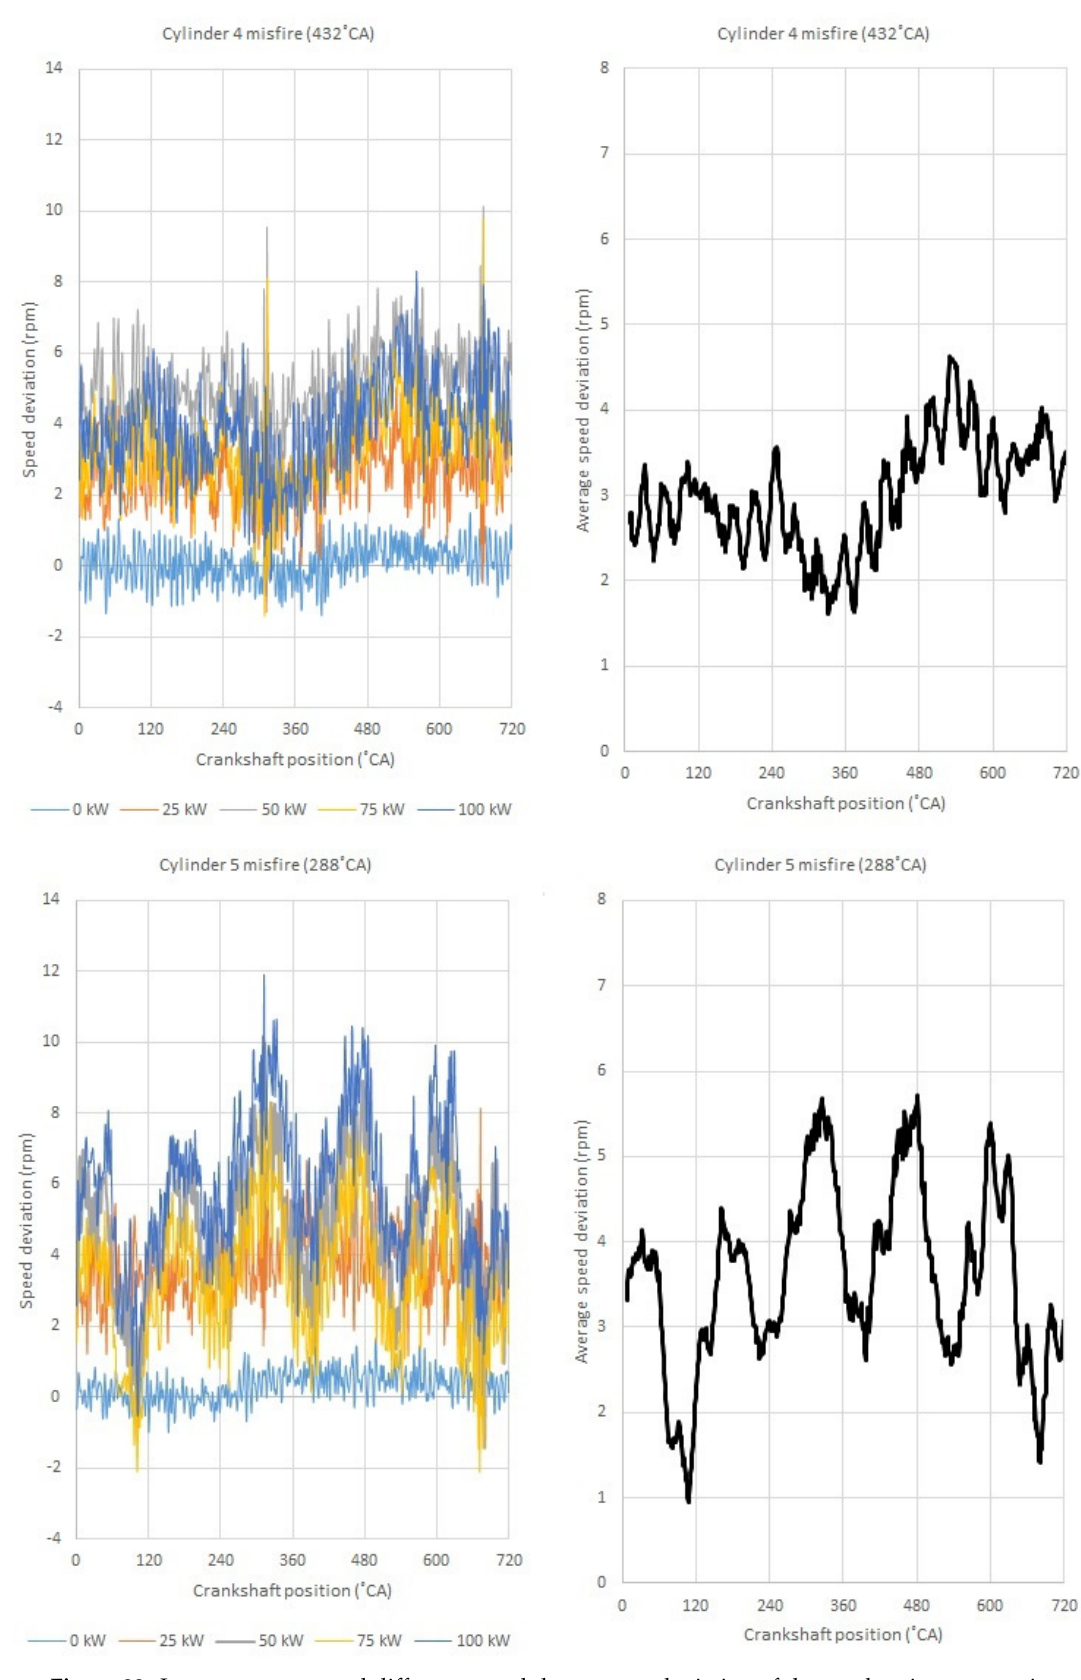
Figure 23. Instantaneous speed differences and the average deviation of the combustion process in cylinders 4 and 5 of a Sulzer 5 BAH 22 engine.